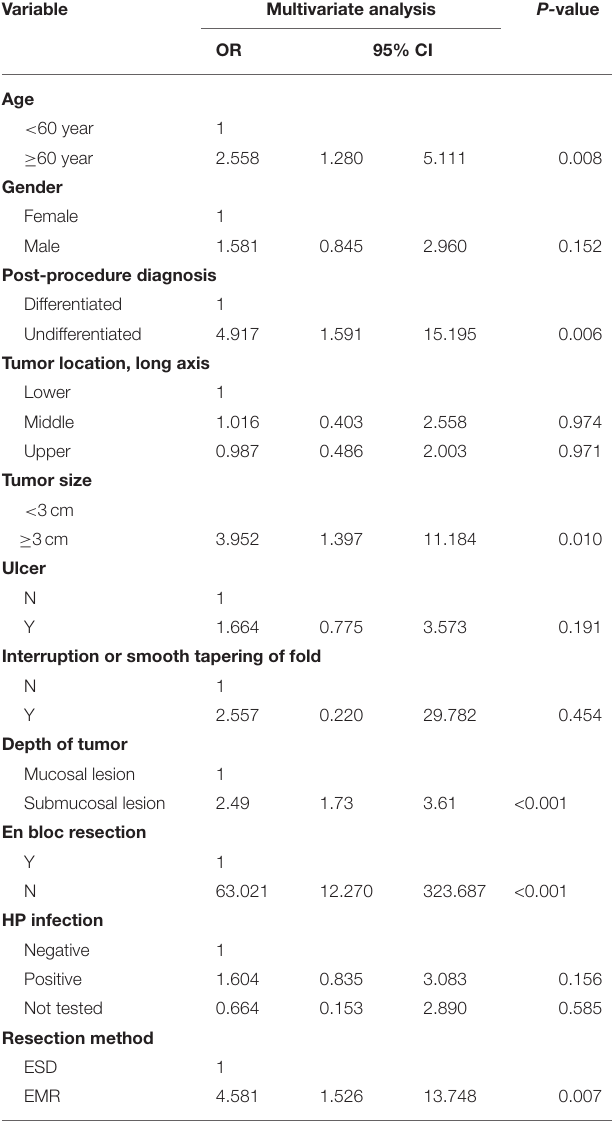
TABLE 2 | Associated factors with non-curative resection of ESD/EMR.